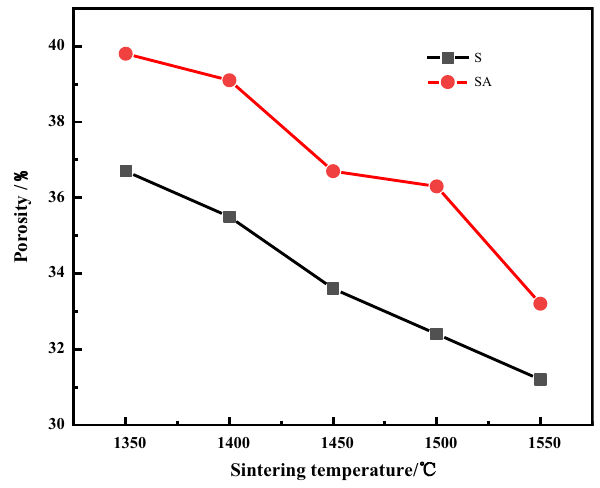
Fig. 5 Porosity of samples sintered at various temperatures for 2 h in the air